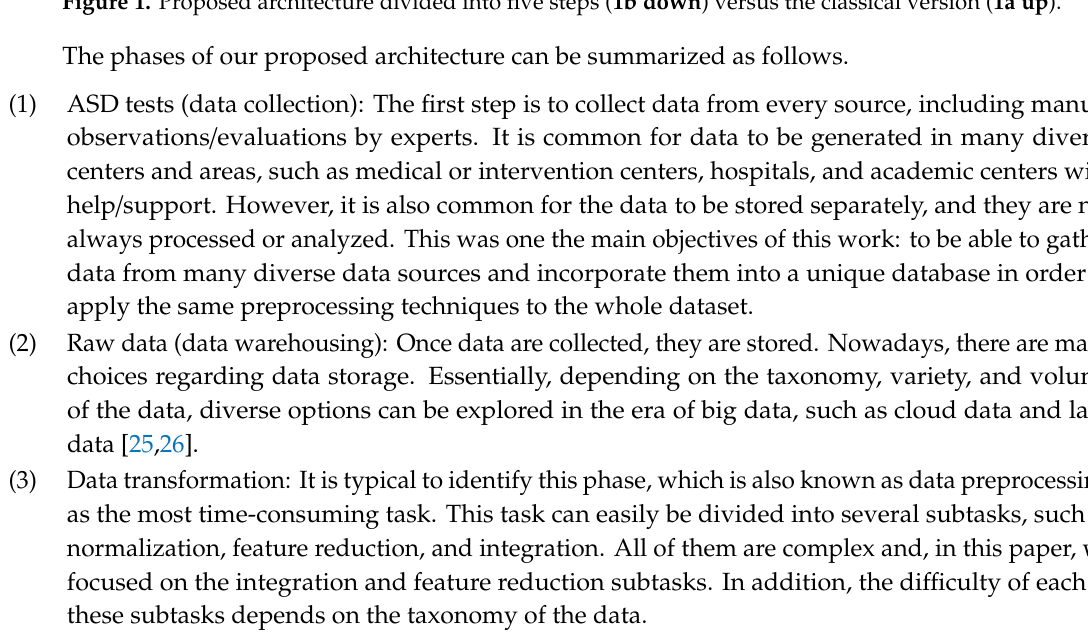
Figure 1. Proposed architecture divided into five steps ( 1b down ) versus the classical version ( 1a up ).